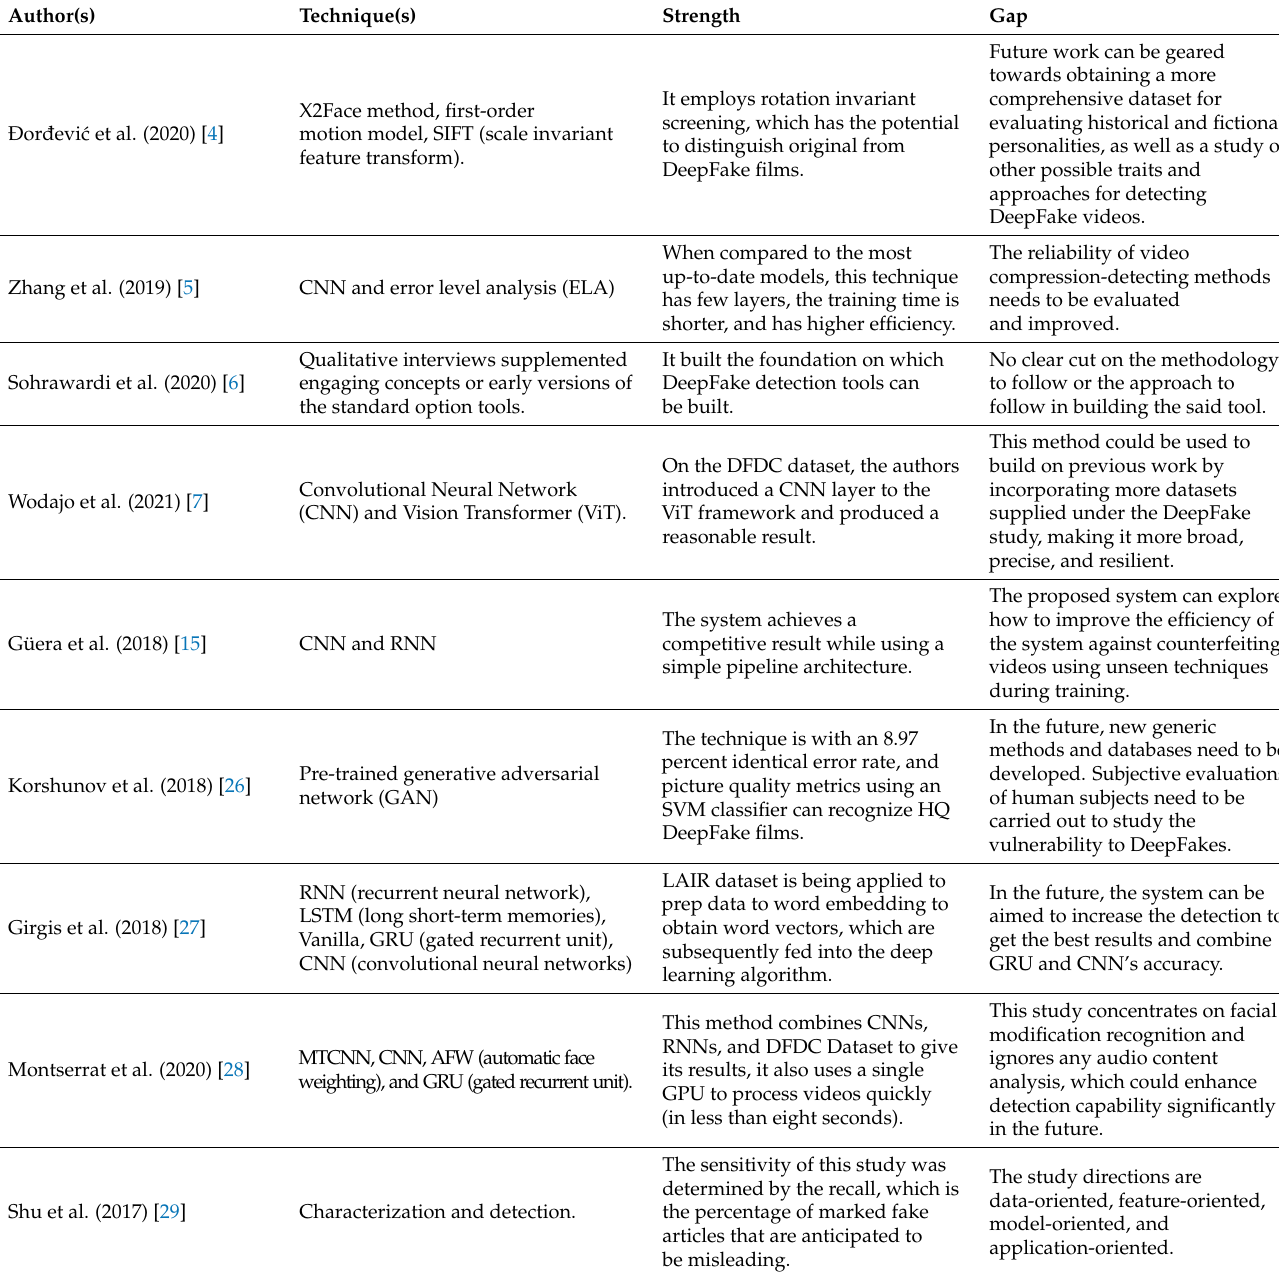
Table 1. Review of selected related work in DeepFake